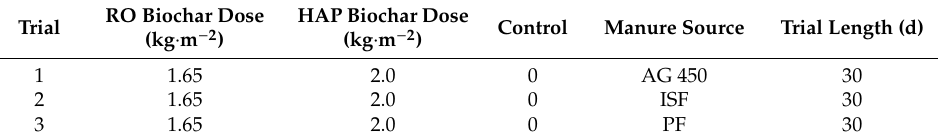
Table 2. Matrix of the